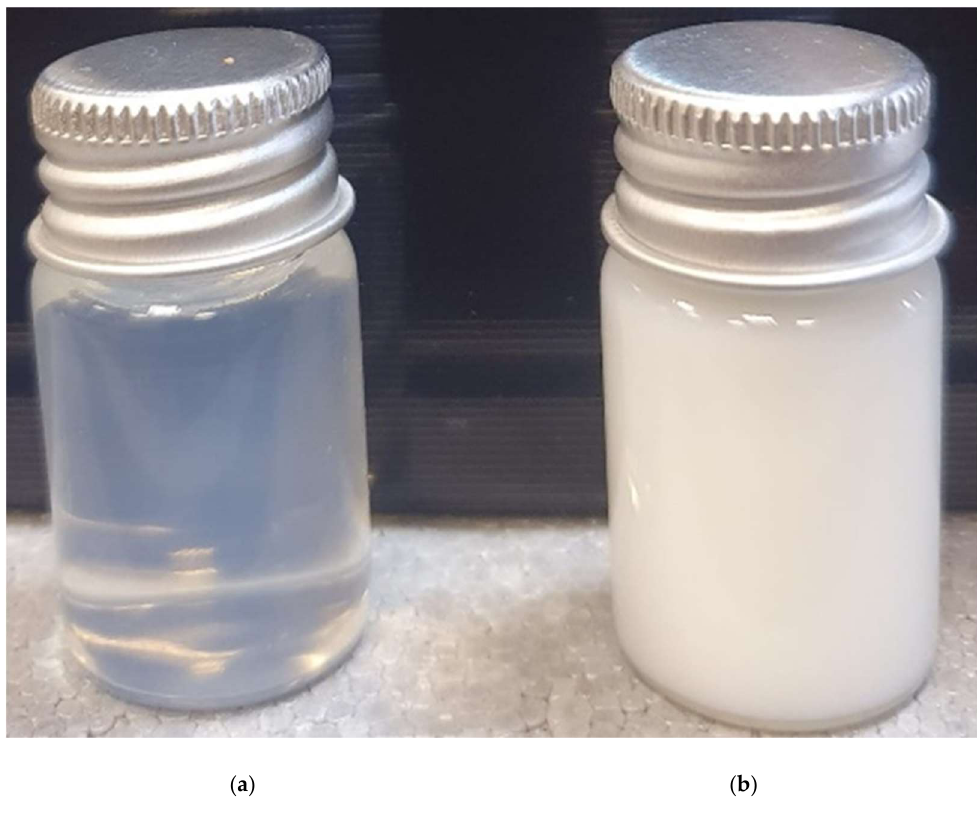
Figure 8. ( a ) SNEDDS; ( b ) CA-SNEDDS.